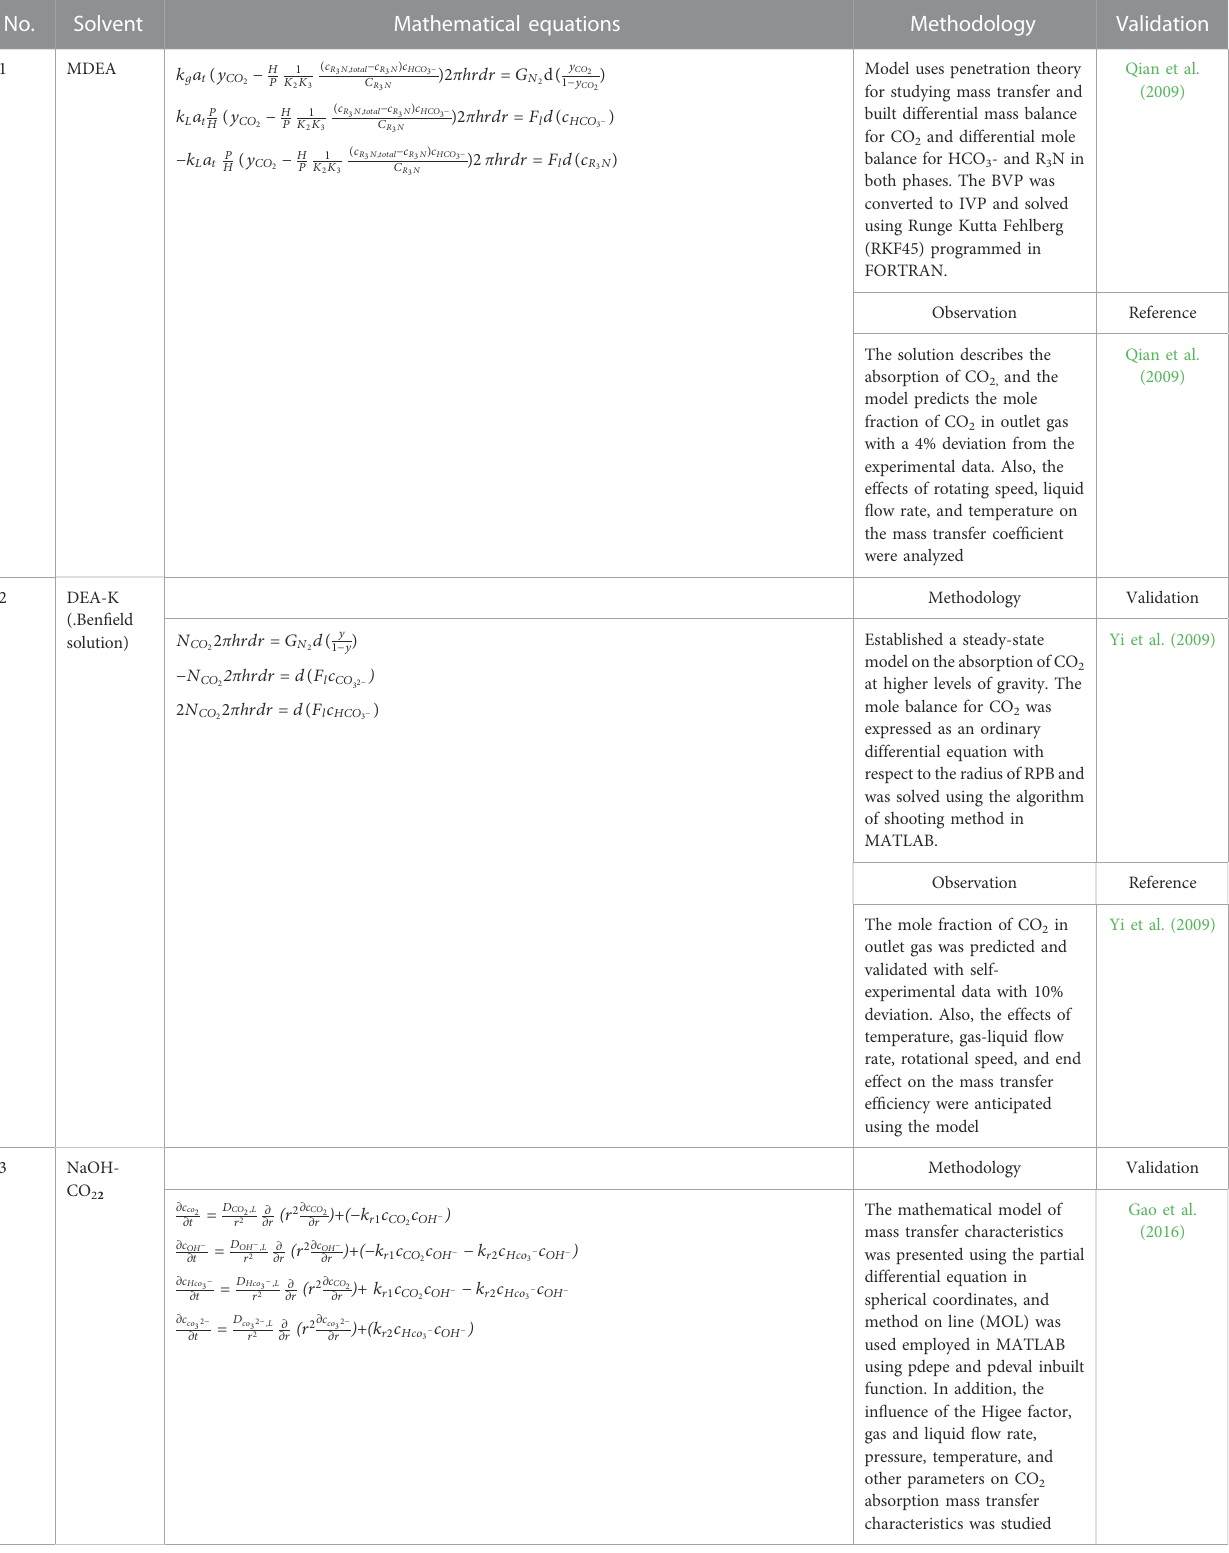
Model uses penetration theory for studying mass transfer and built differential mass balance for CO 2 and differential mole balance for HCO 3 - and R 3 N in both phases. The BVP was converted to IVP and solved using Runge Kutta Fehlberg (RKF45) programmed in FORTRAN.